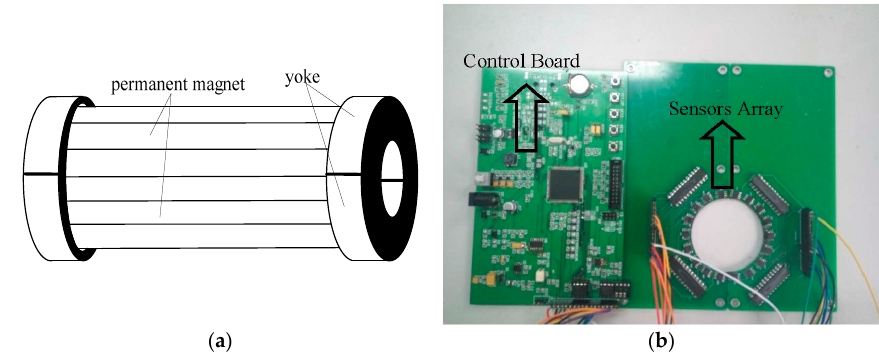
Figure 3. ( a ) Schematic diagram of the excitation device; ( b ) The printed circuit boards employed in the detection system, including the control board and a sensor array board.